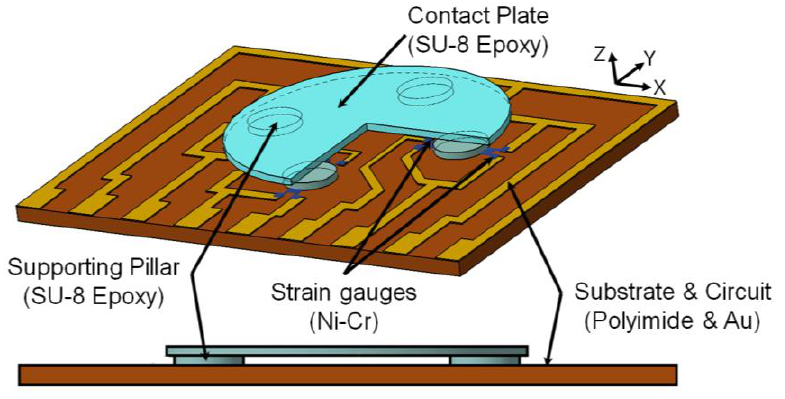
Figure 1. Schematic diagram of the designed sensor and cross-sectional view of the sensing